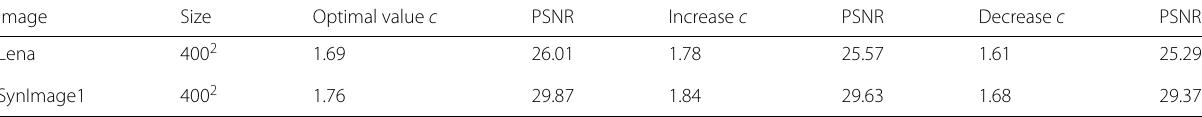
Table 5 Comparison of the image quantity (PSNR values) for different values (increase and decrease) in shape parameter c with the optimal value of shape parameter c of the proposed method M3 for real and artificial images Image Size Optimal value c